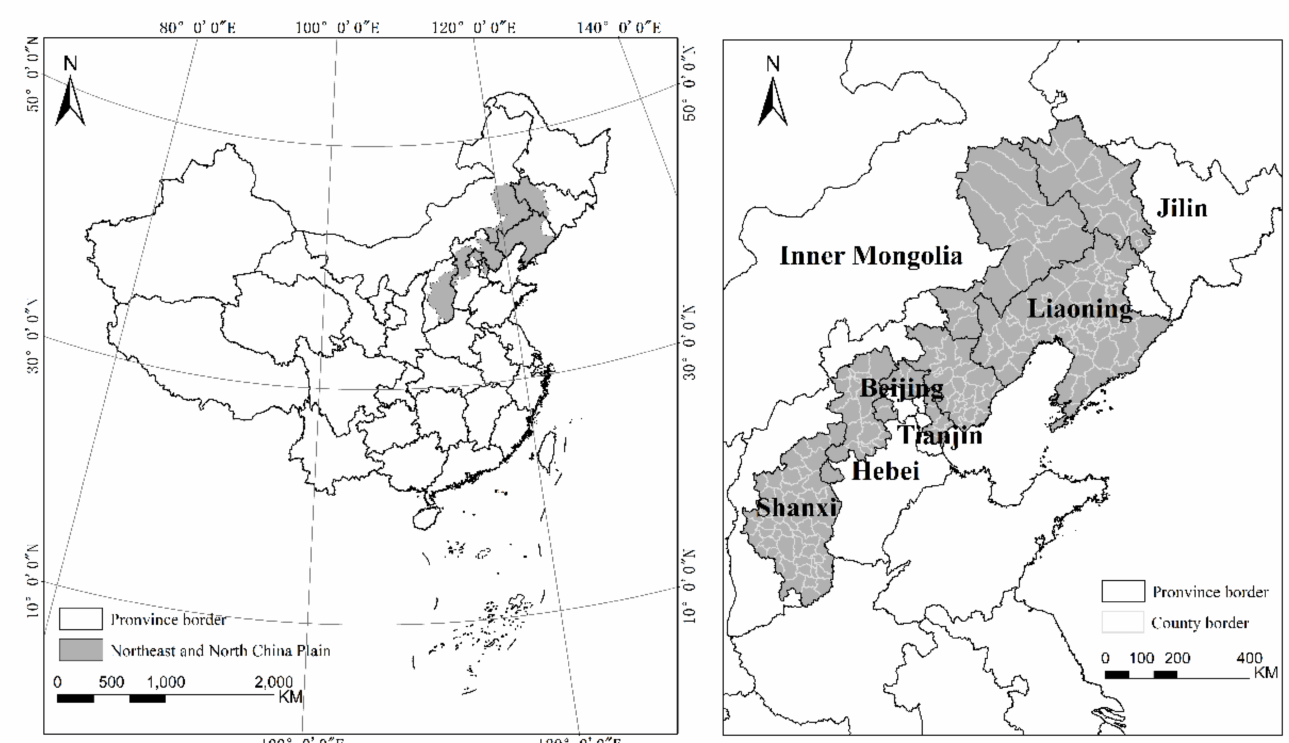
Figure 1. Diagram of the study